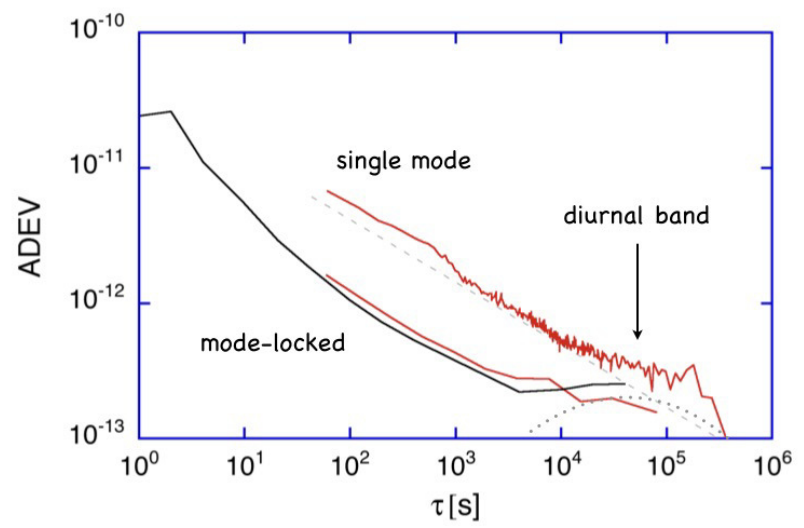
Figure 1. The performance of the G ring laser at the Geodetic Observatory Wettzell under different operating